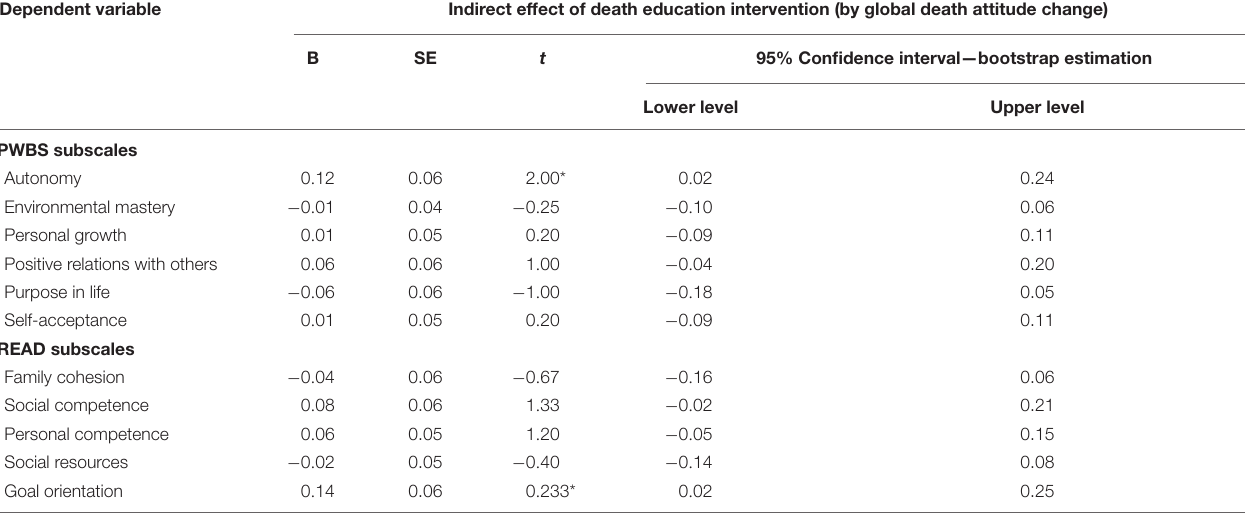
TABLE 3 | Mediation effect of global death attitude change on death education intervention impact on student’s well-being and resilience at the